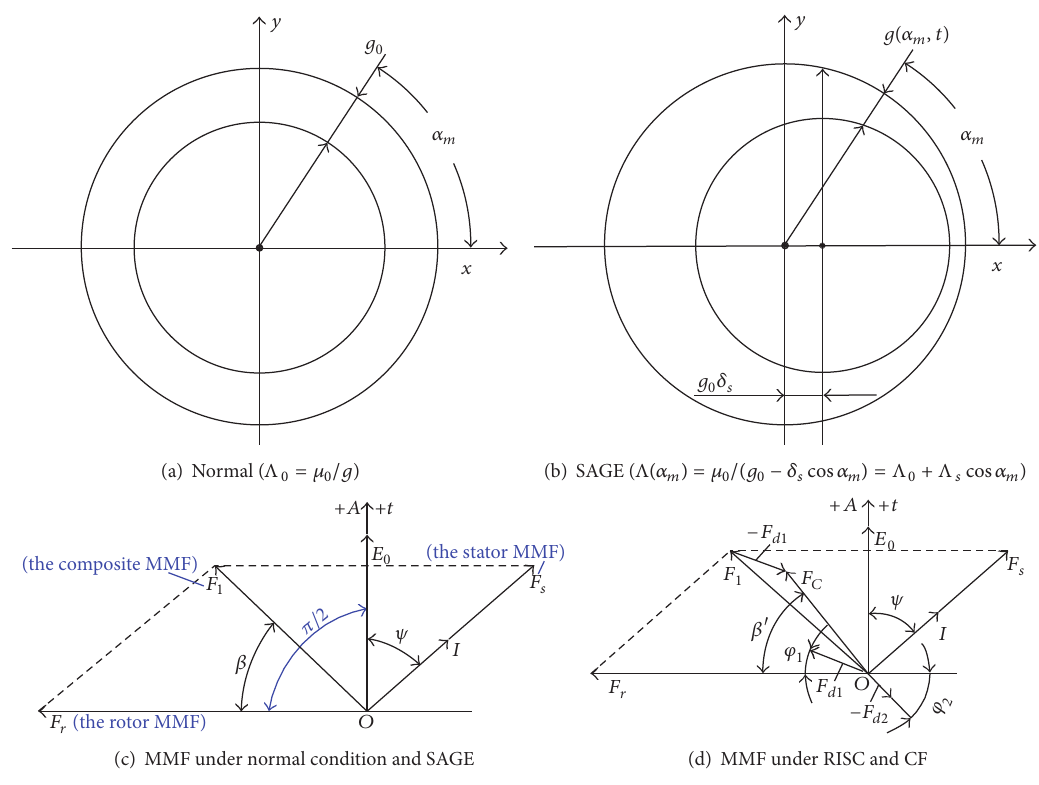
Figure 1: Air gap and MMFs of turbogenerator under different